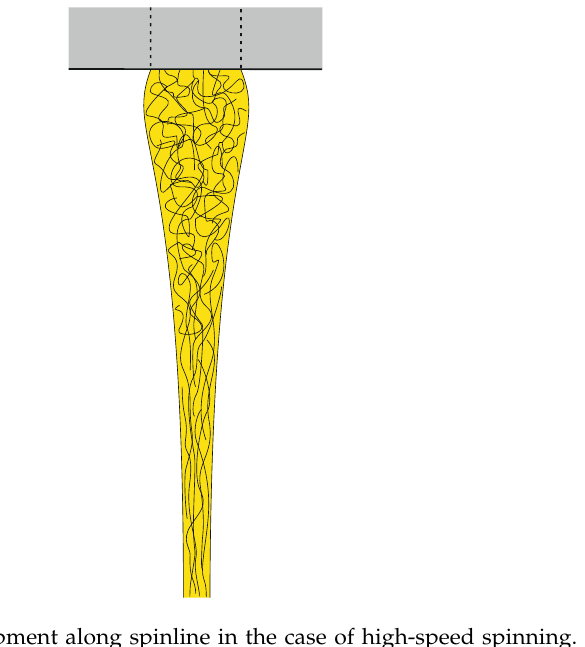
Figure 6. Orientation development along spinline in the case of high-speed spinning. By way of illustration, the polymer melt is represented in yellow.